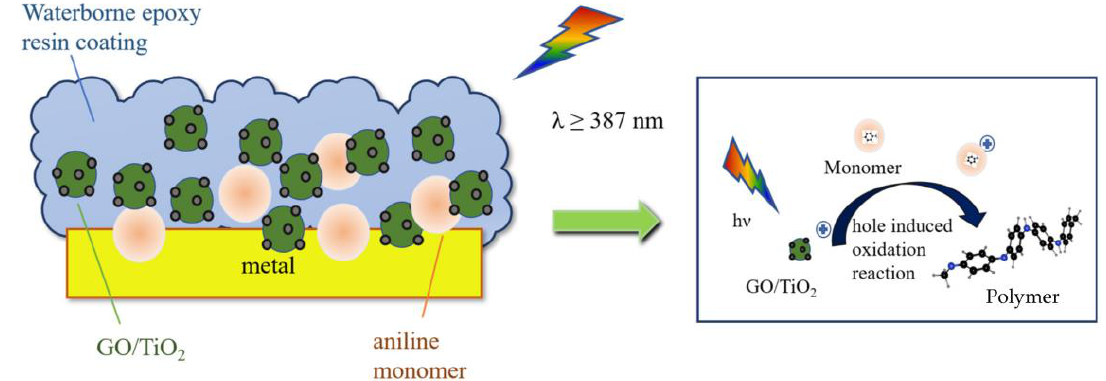
Figure 2. Hole-induced chemistry oxidation process in TiO 2 photocatalysis.